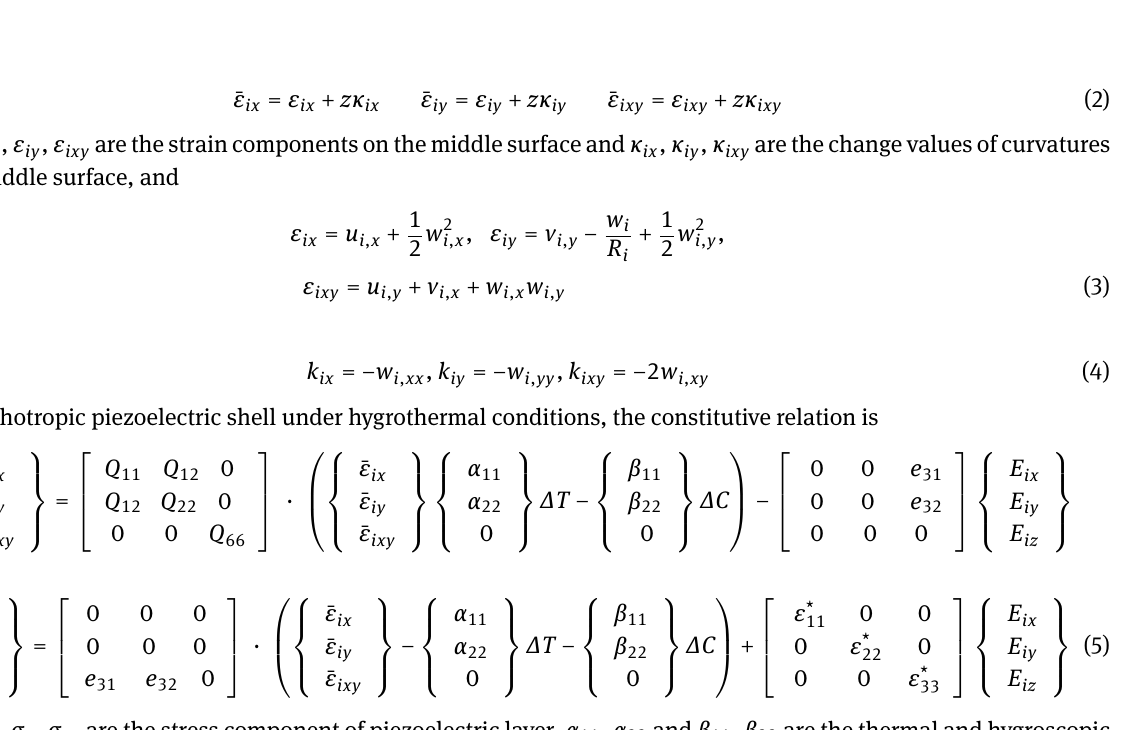
Fig. 1. Geometry of piezoelectric shell with